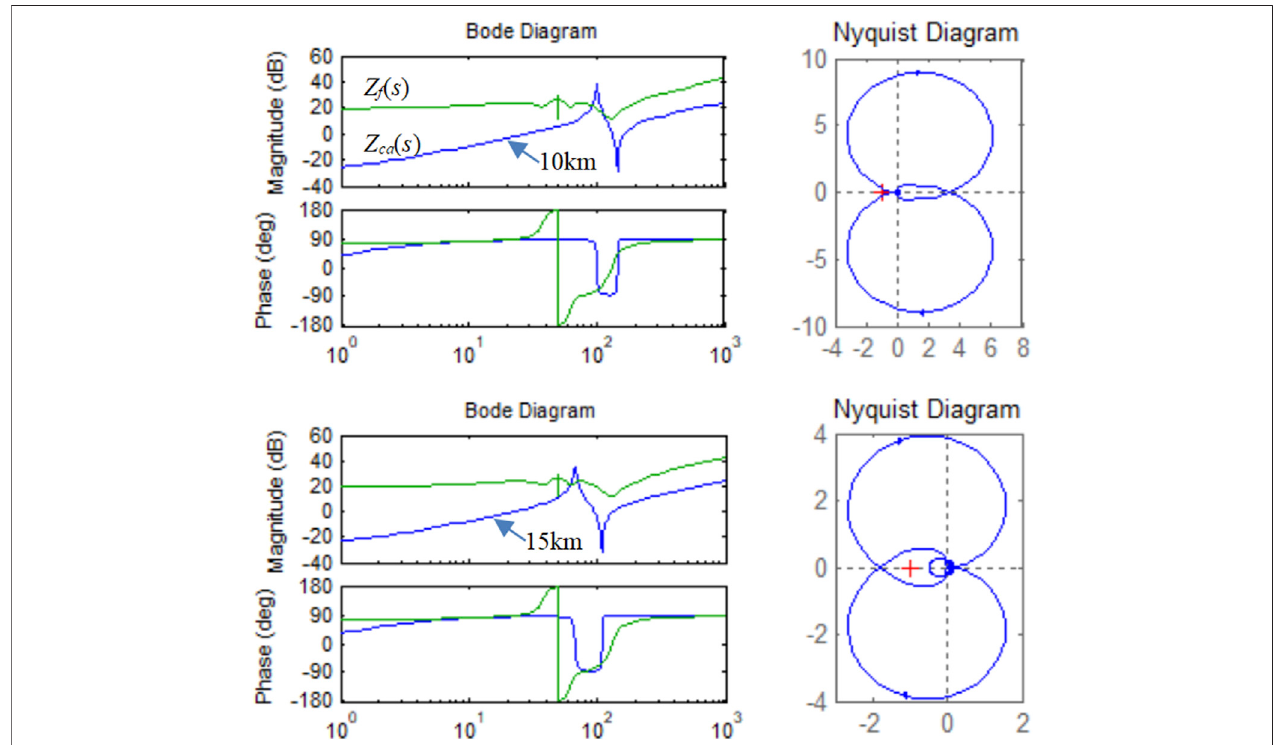
FIGURE 9 | Bode diagrams of Z ca (s) and Z f (s) and Nyquist diagrams of Z ca (s)/Z f (s) for the internal stability analysis based on 35-kV cable of 10 and 15 km.